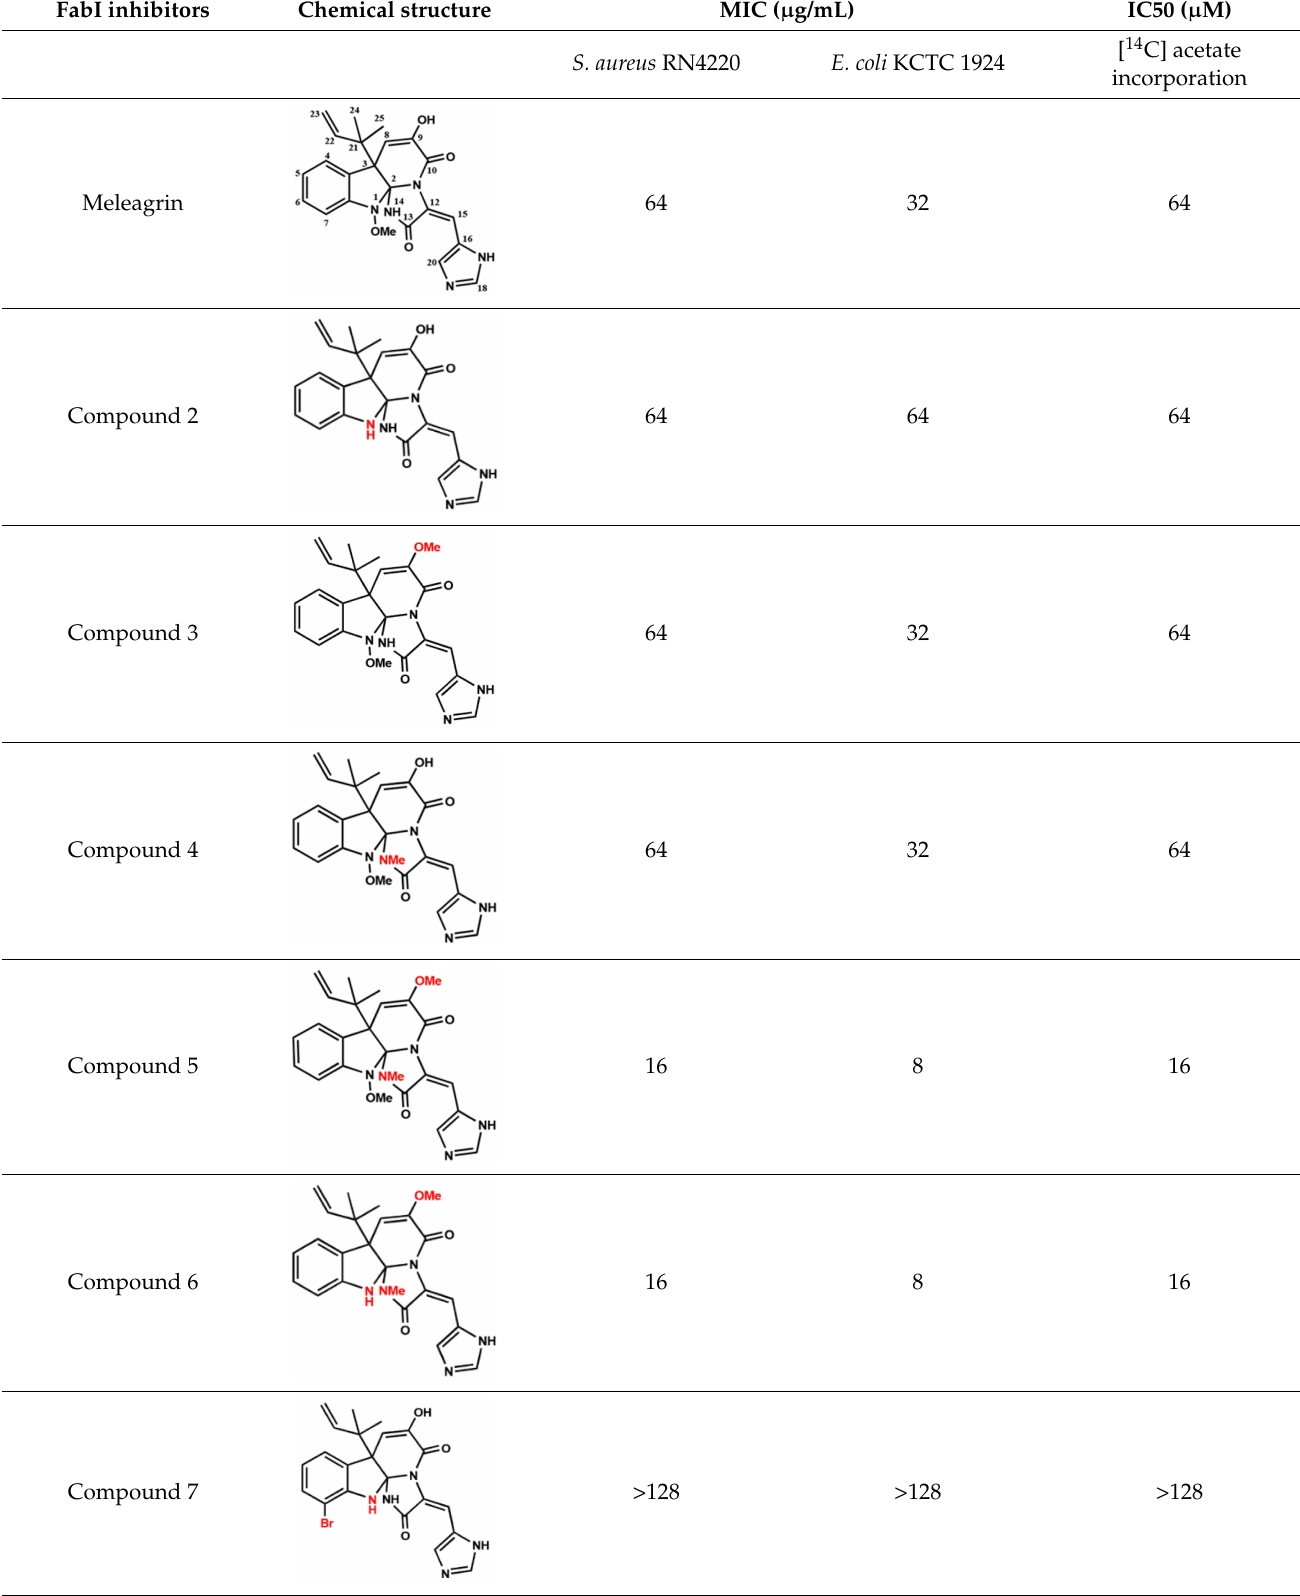
Table 2. Inhibition activity of meleagrin and its chemically prepared derivatives. This table